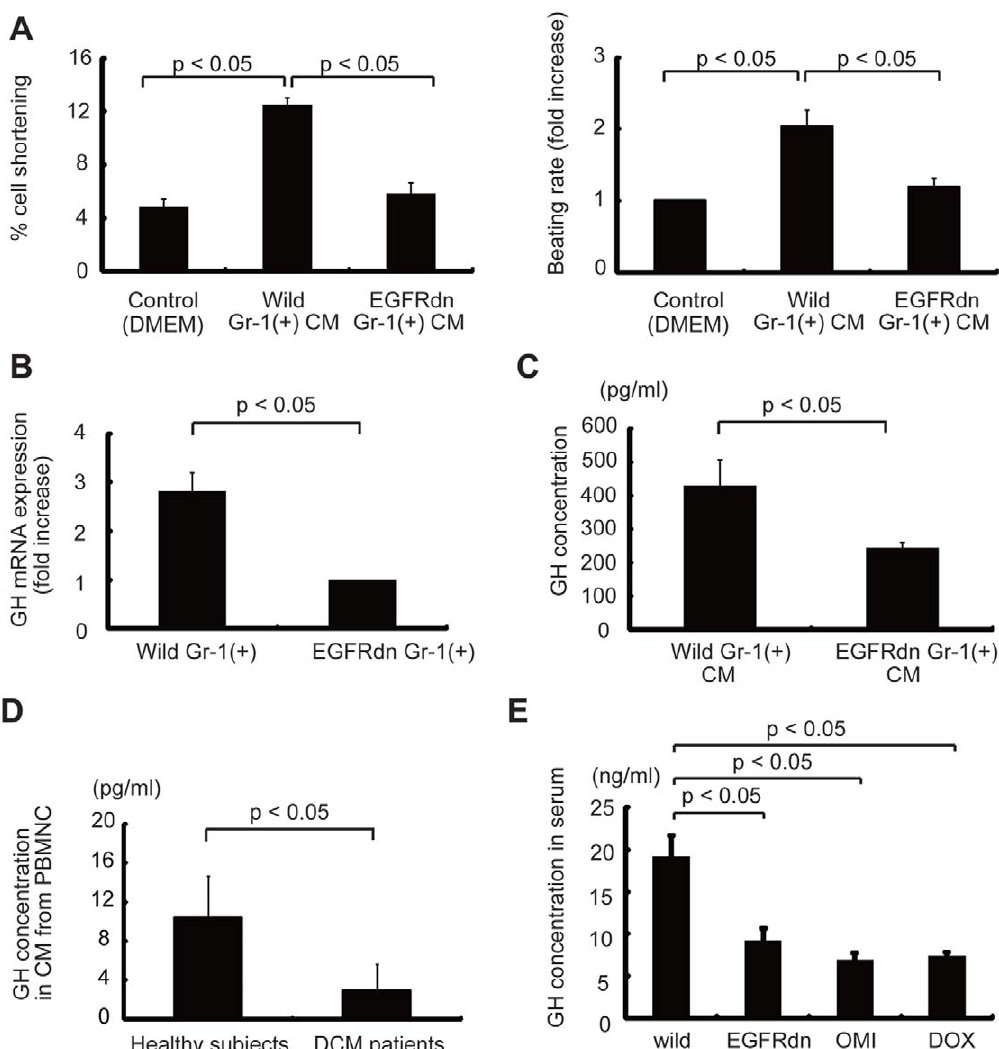
Figure 4. Analysis of secreted factors. (A) CM from Gr-1( + ) cells from wild-type mice significantly improved the cell shortening and increased the beating rate in neonatal rat cardiomyocytes, as compared with CM from Gr-1( + ) cells from EGFRdn mice. Left graph, cell shortening ( n =24 cells per group). Right graph, beating rate ( n =24 cells per group). (B) Quantitative RT-PCR analysis of GH mRNA in Gr-1( + ) cells isolated from wild-type mice and EGFRdn mice ( n =4). (C, D) GH concentrations in (C) CM from Gr-1( + ) cells isolated from wild-type mice and EGFRdn mice ( n =4) and (D) CM from PBMNC isolated from healthy ( n =11) and DCM subjects ( n =10). (E) GH concentration in serum from several mouse models of heart failure ( n =4). Data are means 6